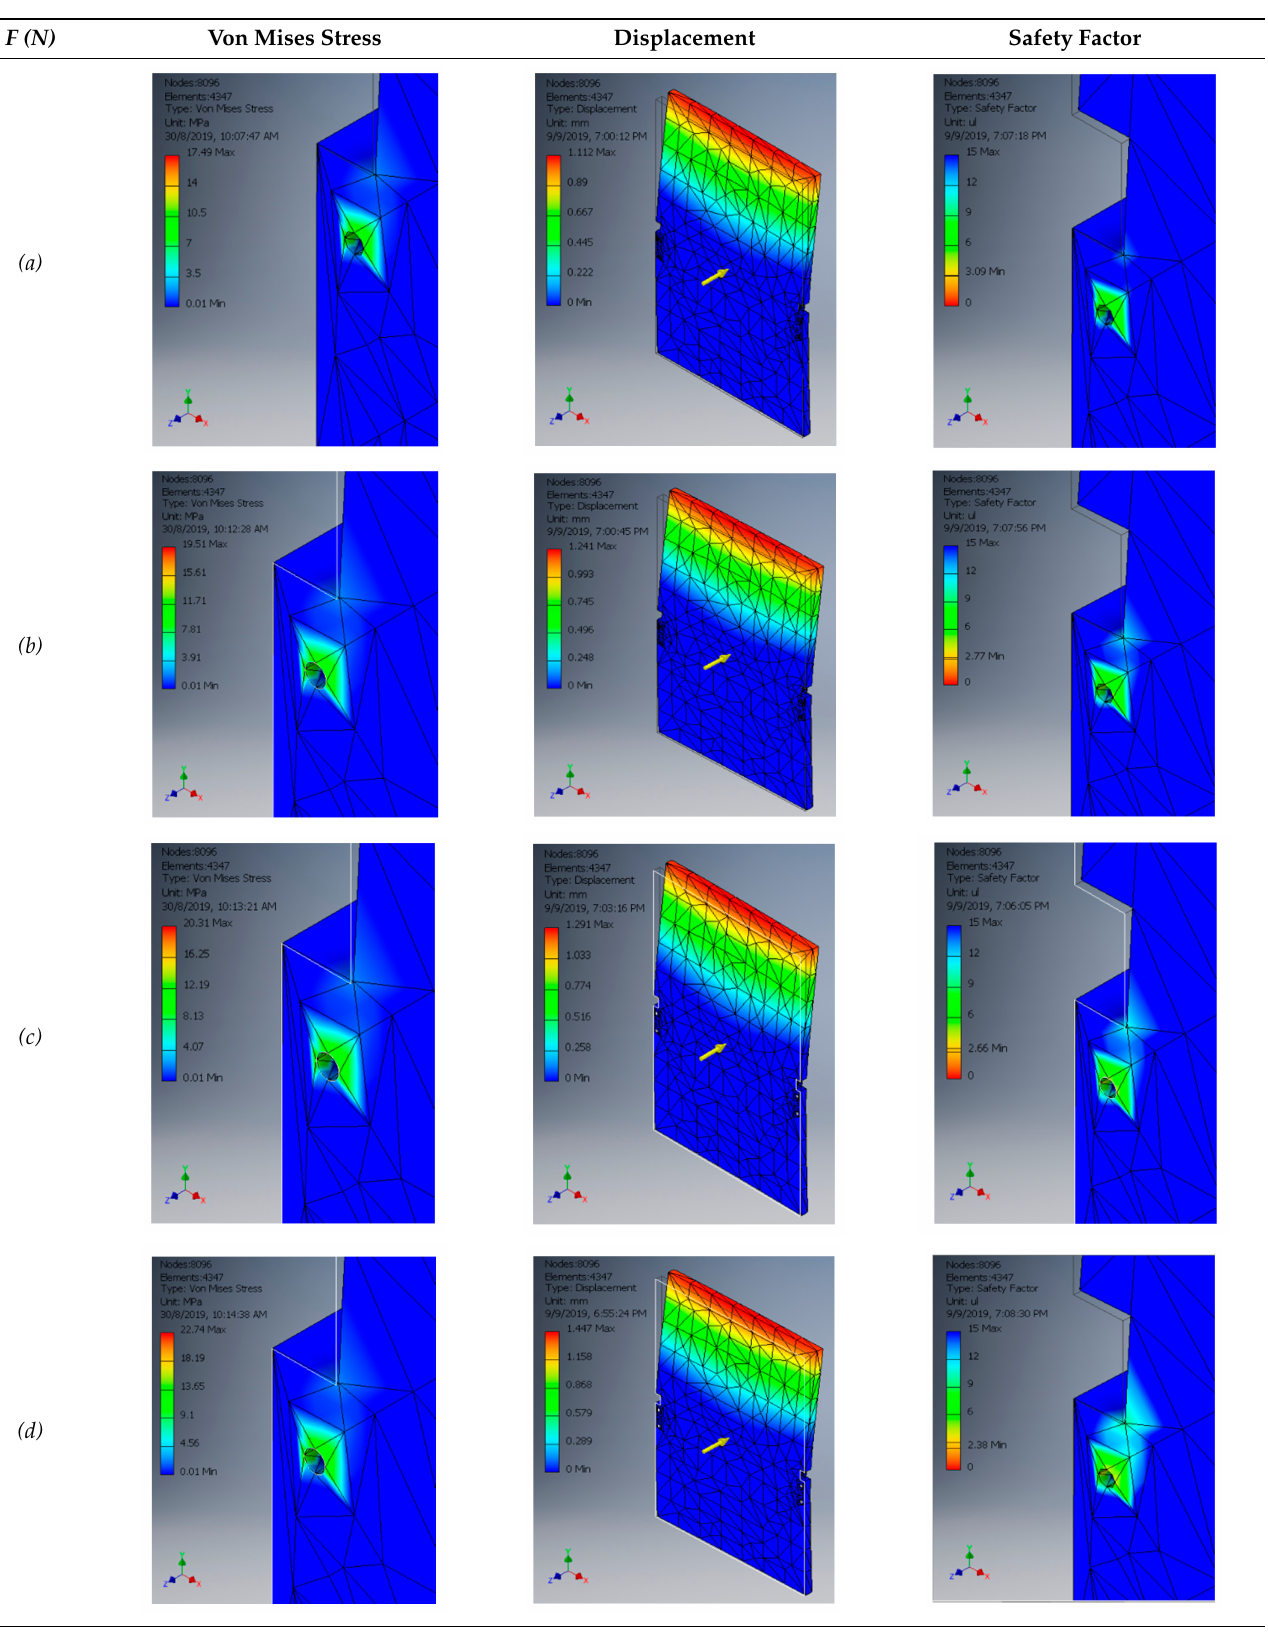
Table 7. Von Mises stress, displacement and safety factor for the platform when applying loads of (a) 536.61 N, (b) 598.41